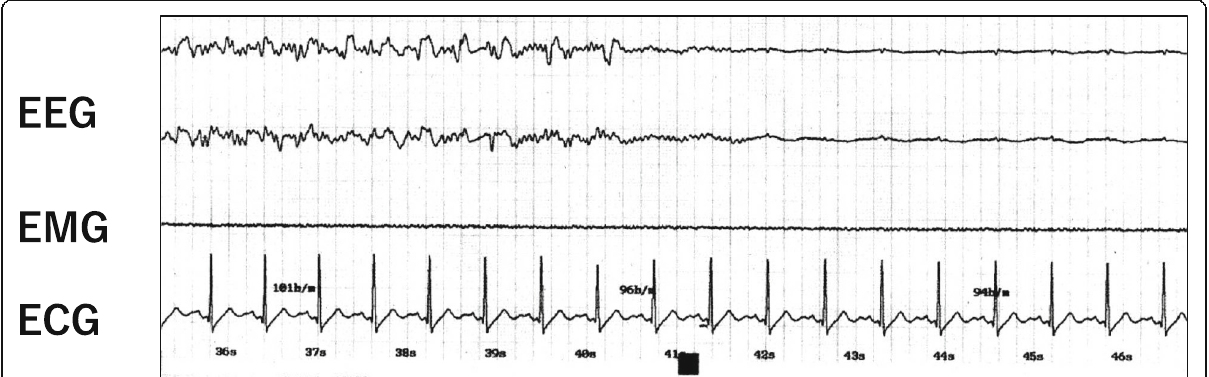
Fig. 2 EEG and ECG changes near seizure termination with administration of atropine sulfate before electrical stimulation. Administration of atropine sulfate prevented severe bradycardia during seizure